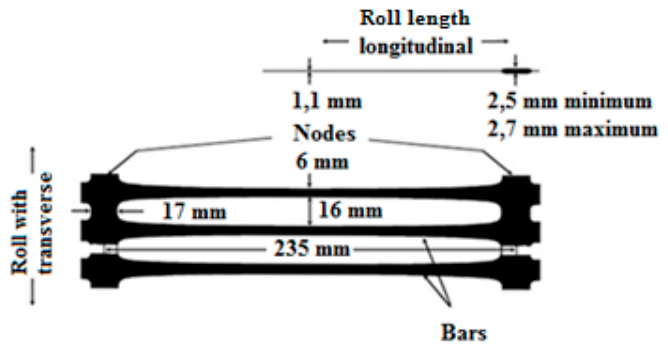
Figure 2. Dimensions of uniaxial geogrid [28]. Table 1. The main engineering properties of the uniaxial geogrid.